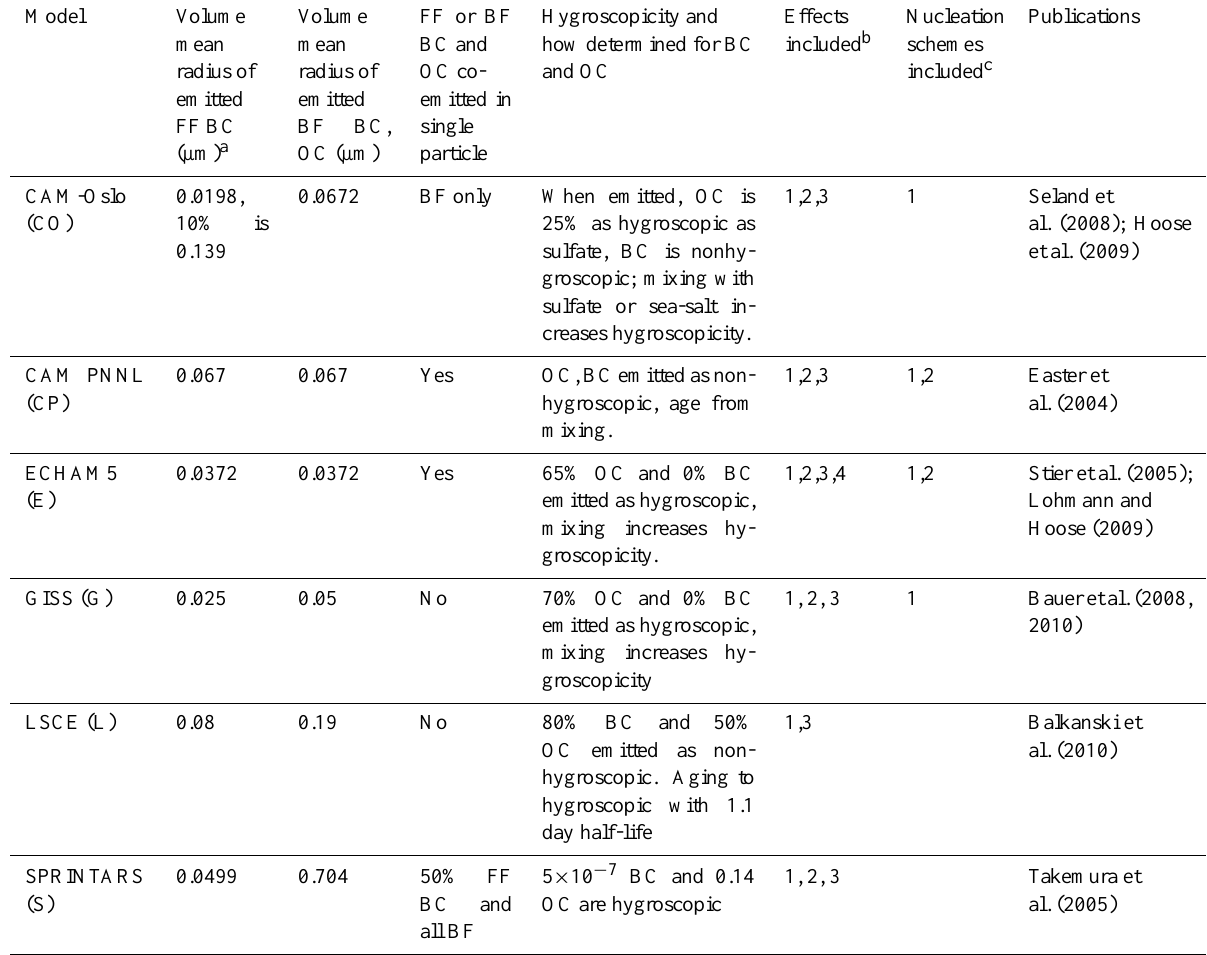
Table 3. Model soot microphysical